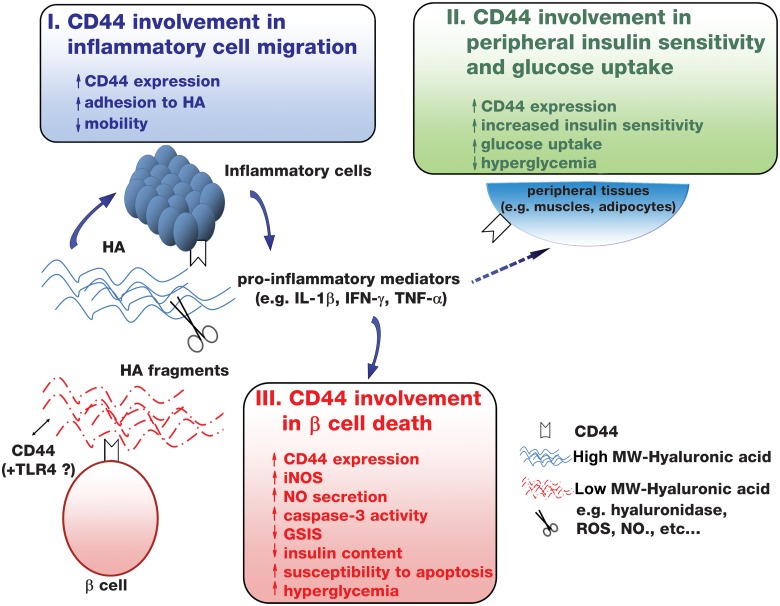
CD44 involvement in T1D.Three CD44-dependent pathways affect the fate of T1D in NOD mice. I. CD44 involvement in inflammatory cell migration (blue). Inflammation upregulates CD44 on the islet-infiltrating cells. The firm adhesion of the CD44 receptor to the HA substrate slows the motility of the inflammatory cells on the endothelium. II. CD44 involvement in peripheral insulin sensitivity and glucose uptake (green). CD44 expression on peripheral tissue, increases insulin sensitivity and glucose uptake by, for example, muscle and liver cells, resulting in reduced hyperglycemia. Compensation for insulin-deficiency (see pathway III) may explain this event. III. CD44 involvement in β cell apoptotic death (red). Inflammation-induced cytokines up-regulate CD44 expression on β cells. CD44 expression on β cells is associated with increased β cell dysfunction and susceptibility to apoptosis, which could be triggered by the binding of HA fragments to CD44 receptor. However, large HA fragments could interfere with the detrimental effect of LMW-HA on β cells. The β cell dysfunction and susceptibility to apoptosis is indicated by increased iNOS induction and subsequent NO production, increased caspase-3 activity (Western blot, not shown), reduced glucose-stimulated insulin secretion, and reduced insulin content. As an outcome of β cell demise, hyperglycemia is detected, implying the development of T1D. Broken arrows and question marks represent pathways and factors that are yet to be established.